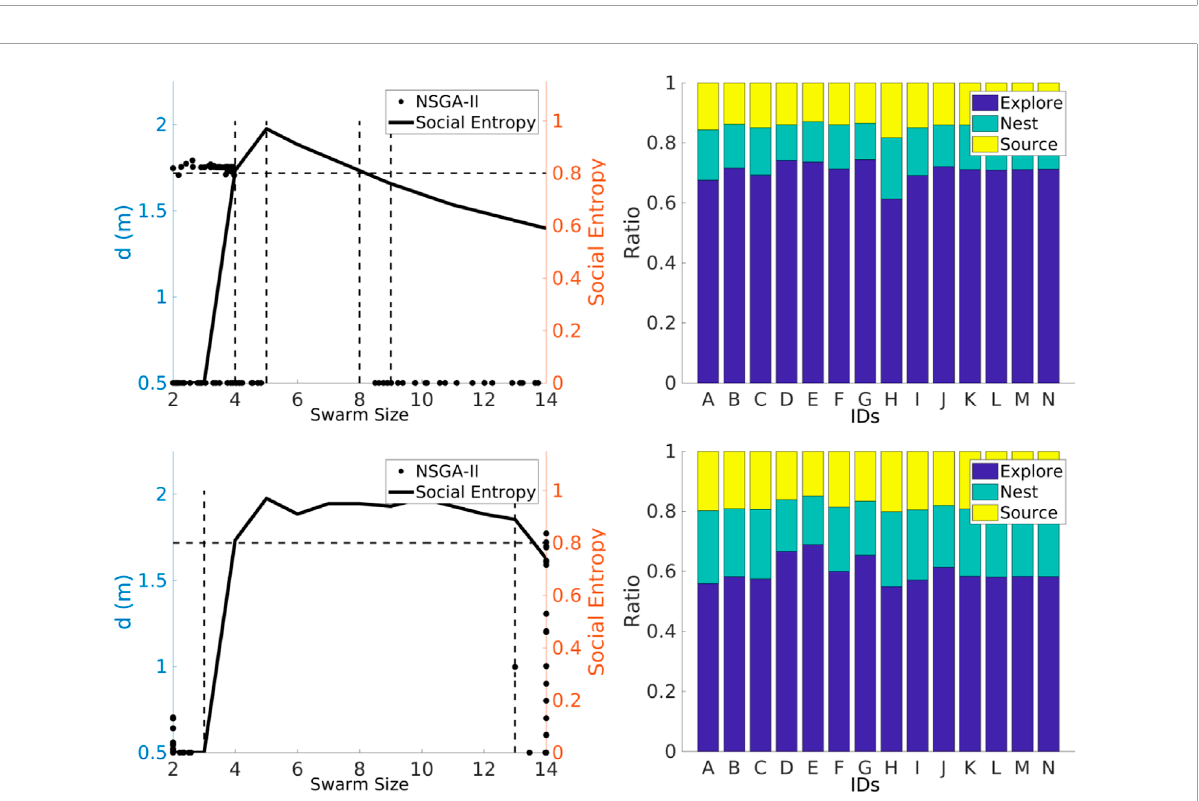
FIGURE 17 Social entropy and individual performance (left and right columns) for each strategy: NPS and DPS (first and second rows, respectively). Social entropy changes for each strategy due to the number of robots classified as having high error.